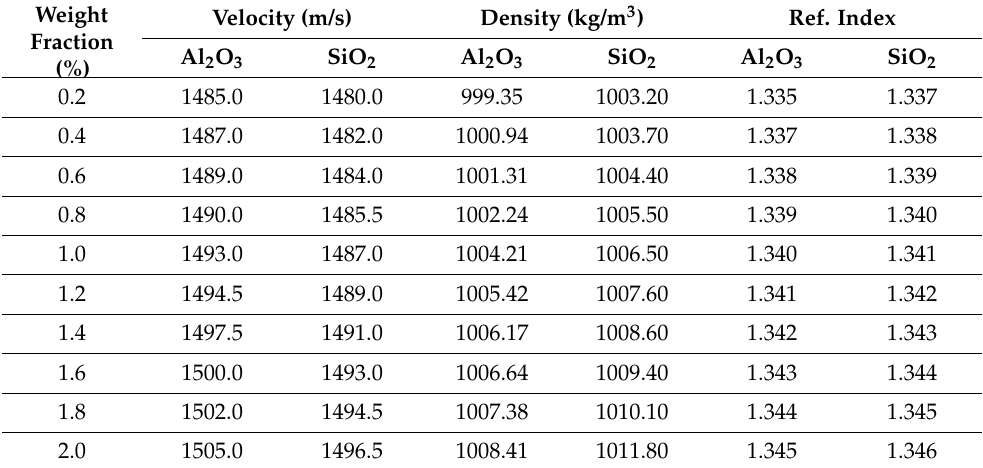
Table 4. Variation in ultrasonic velocity, density, and refractive index values of Al 2 O 3 and SiO 2